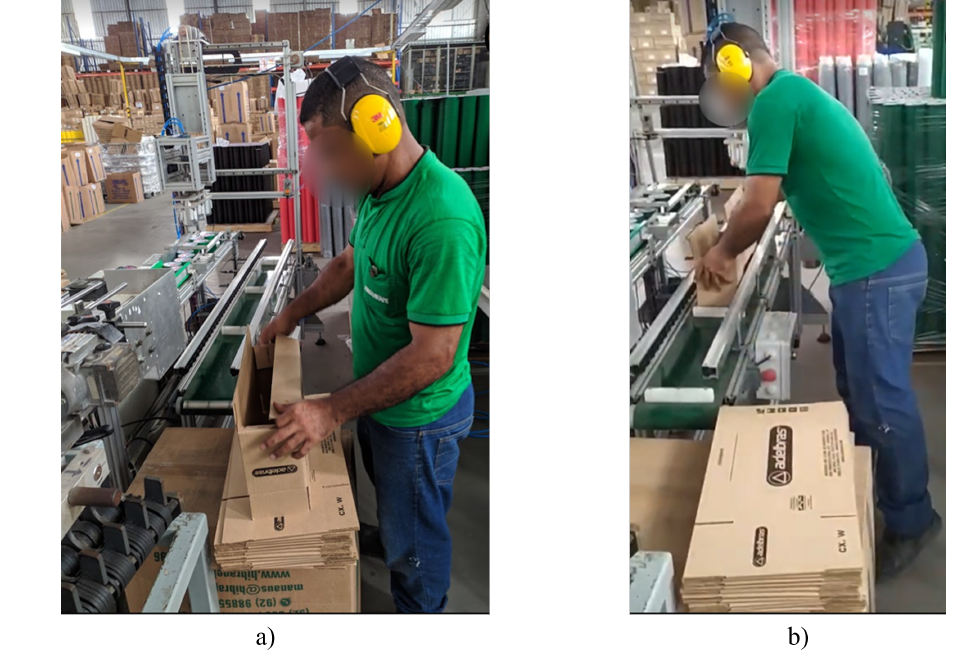
Figure 13. Box assembly ( a ) and positioning operation ( b